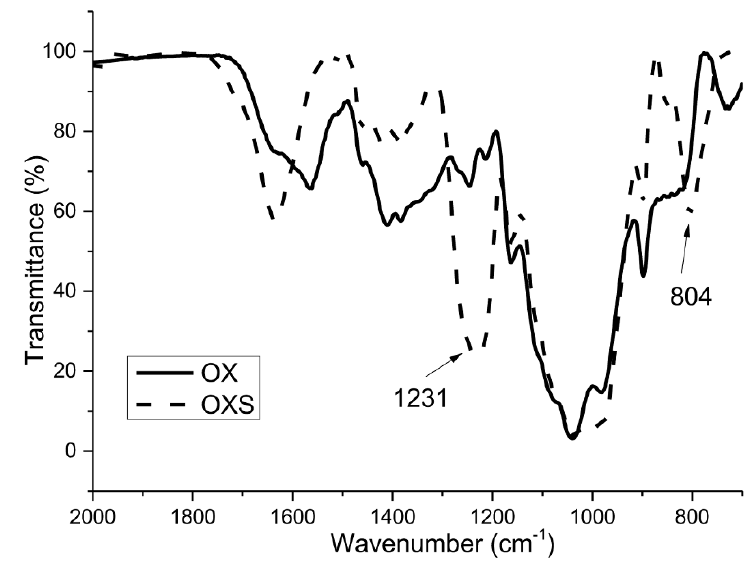
Figure 2. FTIR spectra of non-sulfated (OX) and sulfated (OXS) arabinoxylan samples.